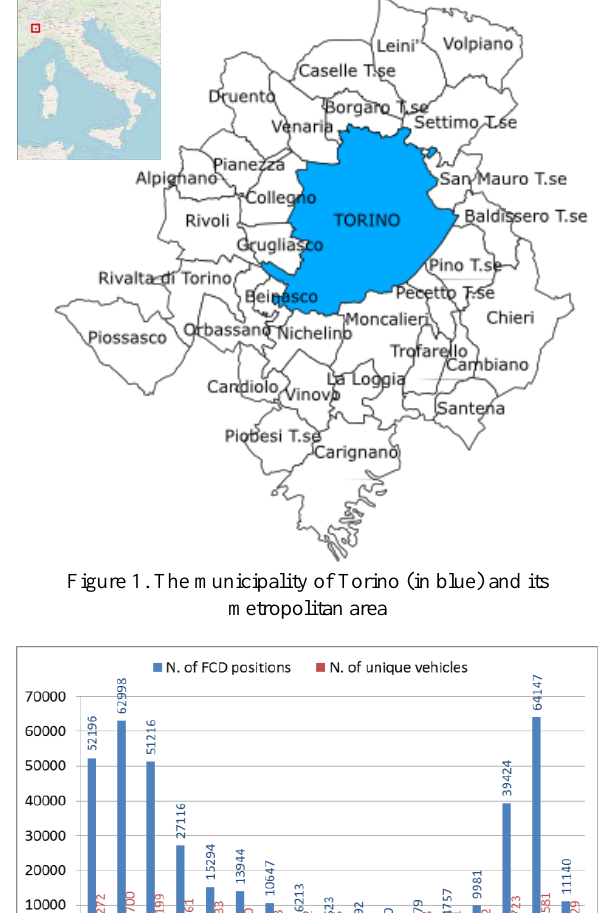
Figure 2. Number of records and unique vehicles in each one hour interval for the available sample of FCD